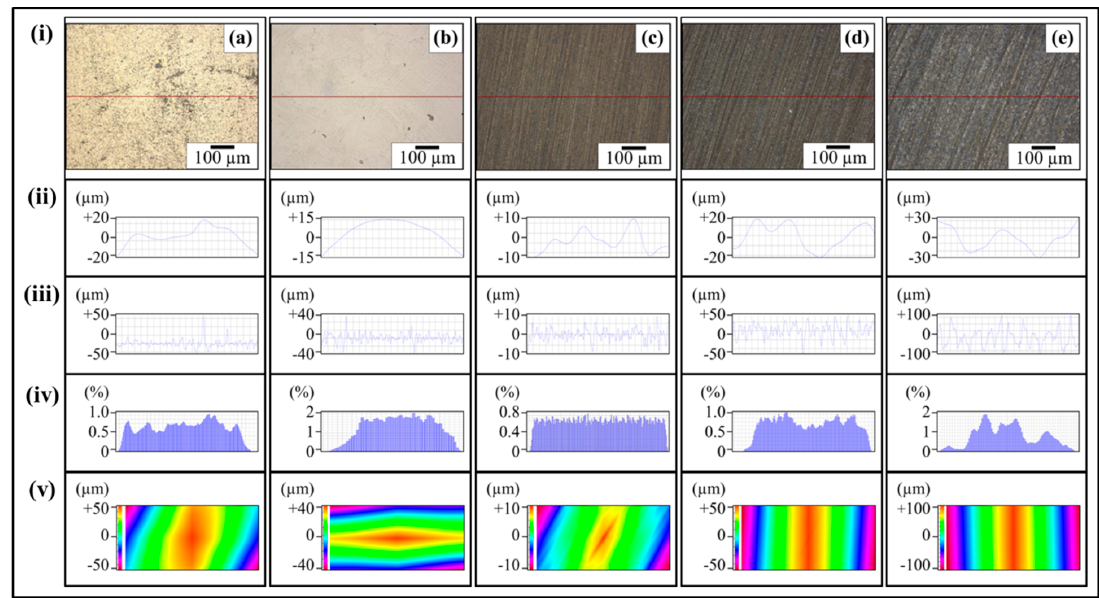
Figure 9. Topographical features of 0.1 wt % clay-EP nanocomposites.